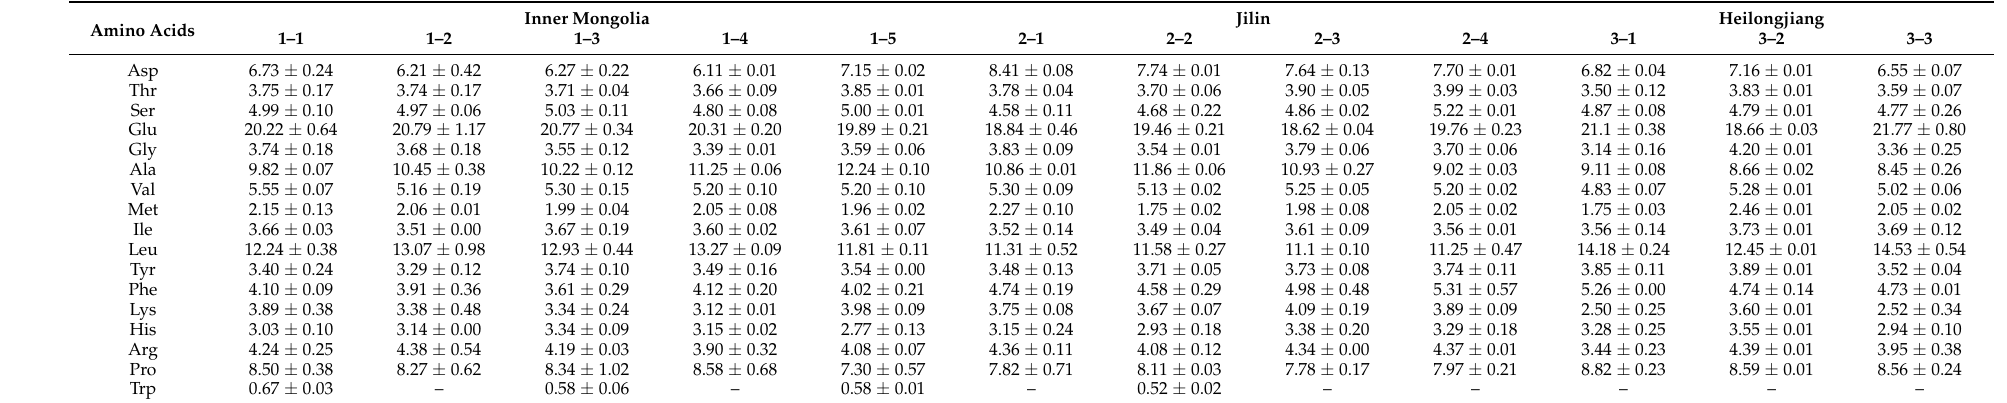
Table 3. Percentages (%) of 17 amino acids in fresh sweet–waxy corn from different